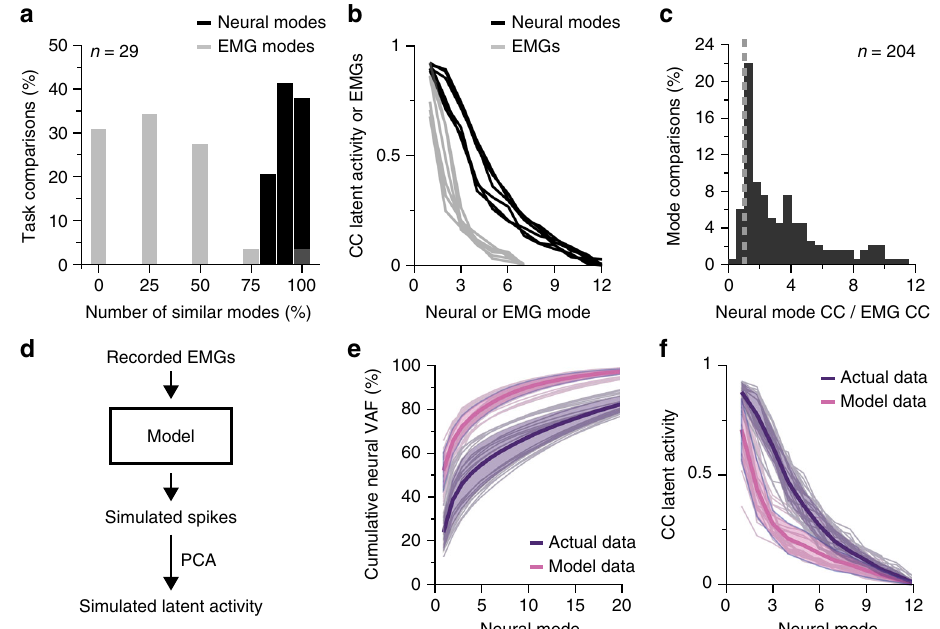
Fig. 5 Similarities in latent neural activity are not accounted for by similarities in motor output. a Comparison between the percentage of neural modes and EMG modes that are preserved across tasks using principal angles; histogram shows the percentage of principal angles smaller than the P < 0.001 signi fi cance threshold. Neural manifold: 12-D, EMG manifold: 4-D; data pooled over all tasks, sessions, and monkeys. b Example comparison of canonical correlations (CCs) for latent neural activity (black) and EMGs (gray); all pairwise comparisons across wrist tasks for one session from Monkey J. Each of the six pairwise comparisons for four wrist tasks is shown as a separate trace. c Histogram of the ratio of the pairwise CCs for latent neural activities to the pairwise CCs for EMGs across tasks (as shown in b ). Data pooled over all tasks, wrist sessions, and monkeys. Most ratios are quite above one (dashed vertical line). d Neural activity was simulated as weighted linear combinations of the recorded EMGs; the neural manifold and latent activity were then computed for the simulated data. e Variance accounted for (VAF) as function of the number of neural modes for the simulated and the actual neural data. Data pooled over all monkeys, wrist sessions, and tasks; thick trace and colored strip: mean ± s.d.; colored traces: individual task comparisons. f The pairwise CCs were signi fi cantly smaller for the simulated than for the actual neural data (same data as in e